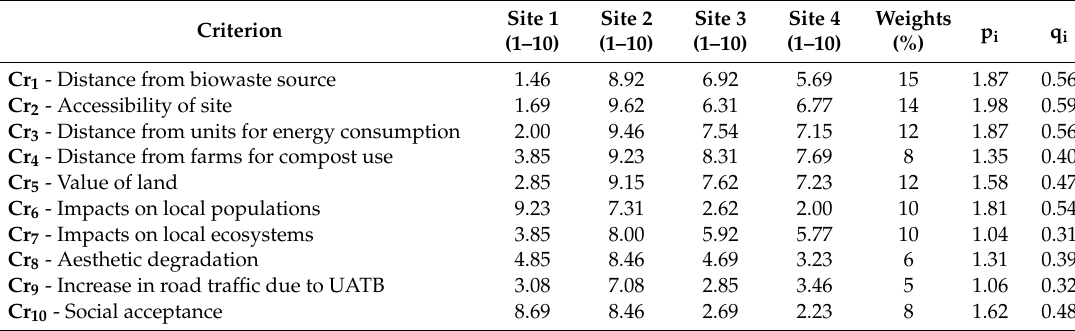
Table 2. Assessment of alternative site locations ( in 1–10 scale, where 10 is the most preferable